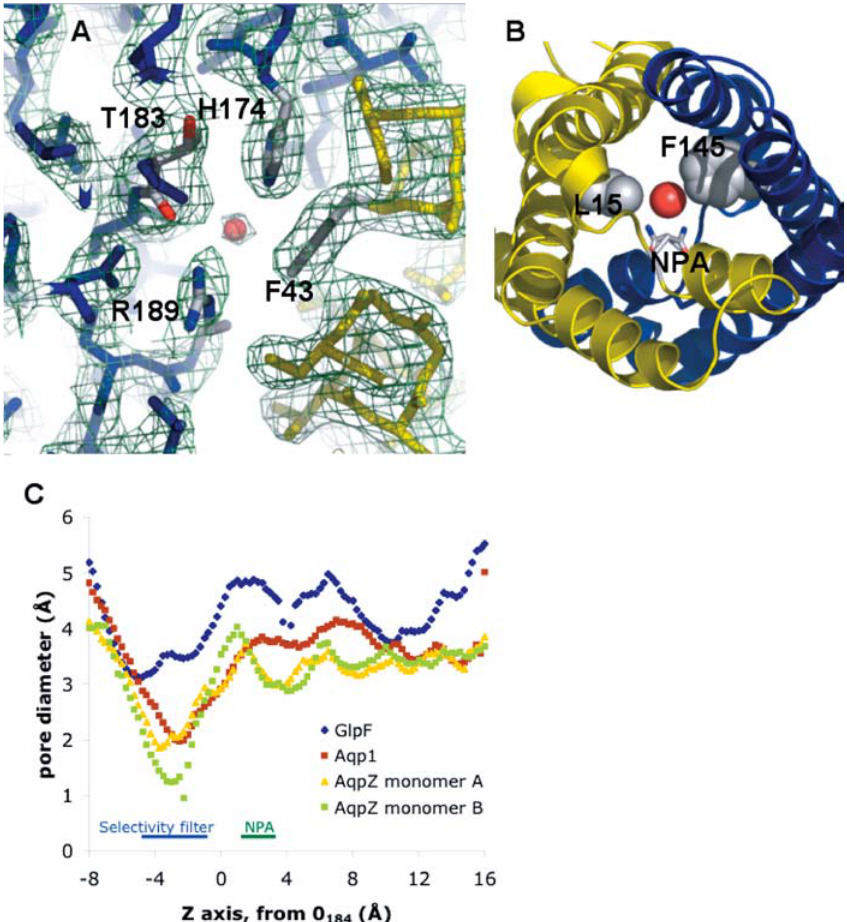
Figure 2. Channel Constriction in Aqua- porins (A) A view of the aquaporin selectivity filter from the periplasmic side. Exper- imental electron density (2F obs – F calc ) is contoured at 1.1 r . (B) Secondary constriction at the NPA motif due to F145 and L15. The drawn water is HOH1032, hydrogen-bonded to the NPA motif asparagines. (C) Pore diameters for the aquaporin X- ray structures, calculated with HOLE2. The AqpZ monomers (protomers) A and B refer to the crystallographically dis- tinct monomers in the unit cell. DOI: